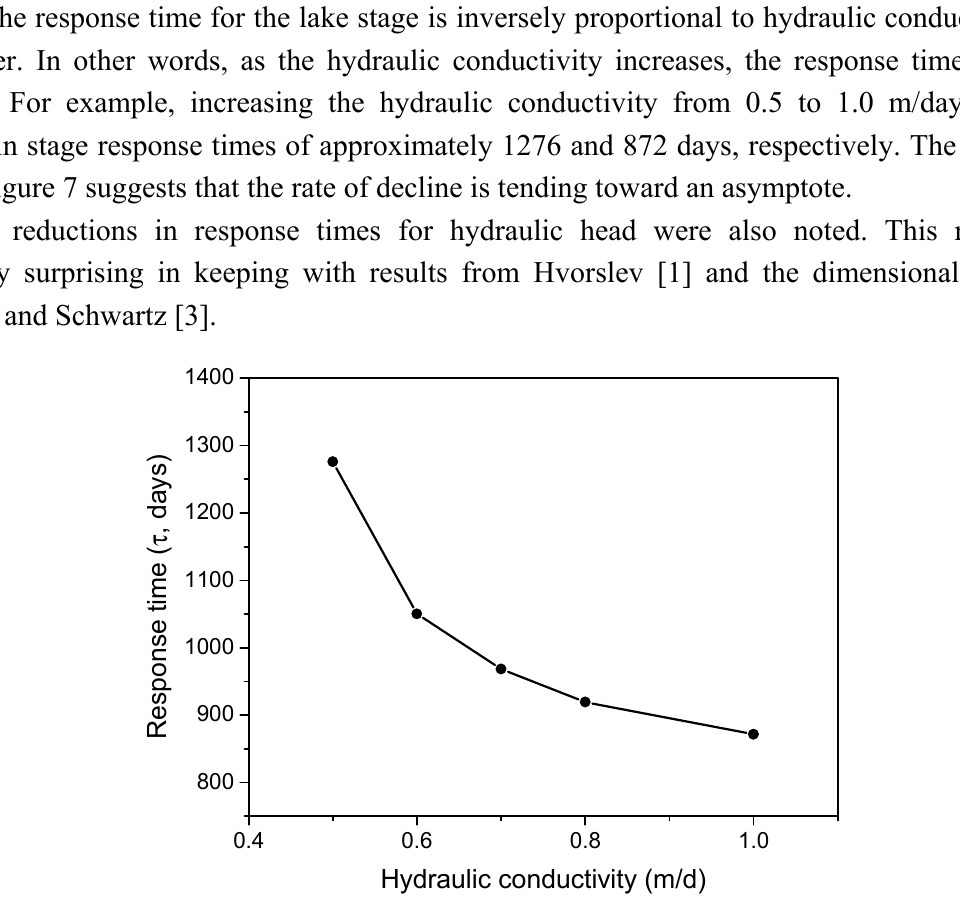
Figure 7. Relationship between hydaulic conductivity and the response time of lake stage to the climatic